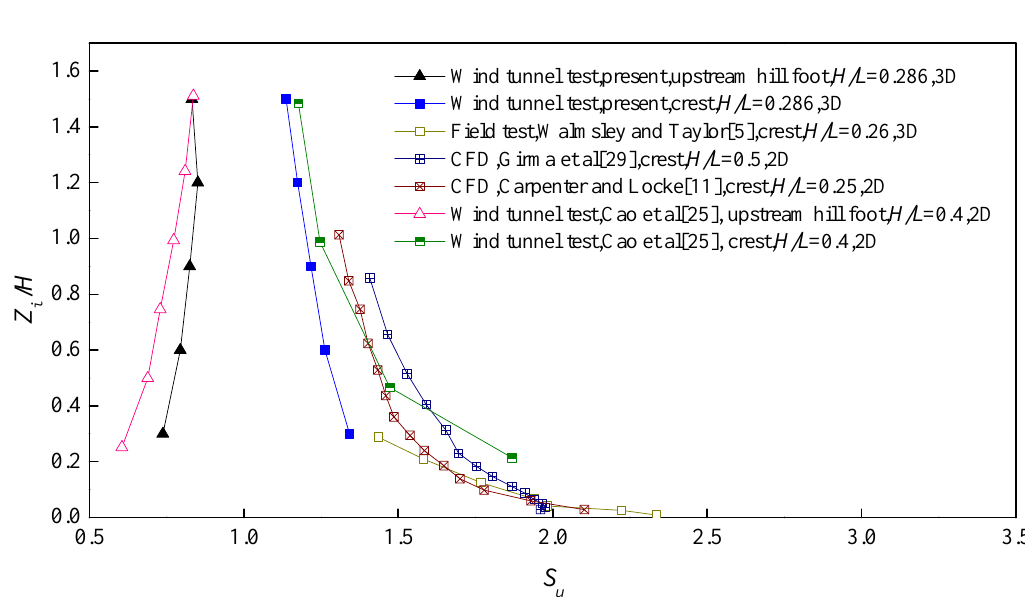
Figure 14. Comparison of speed ‐ up S u between tests and other studies.